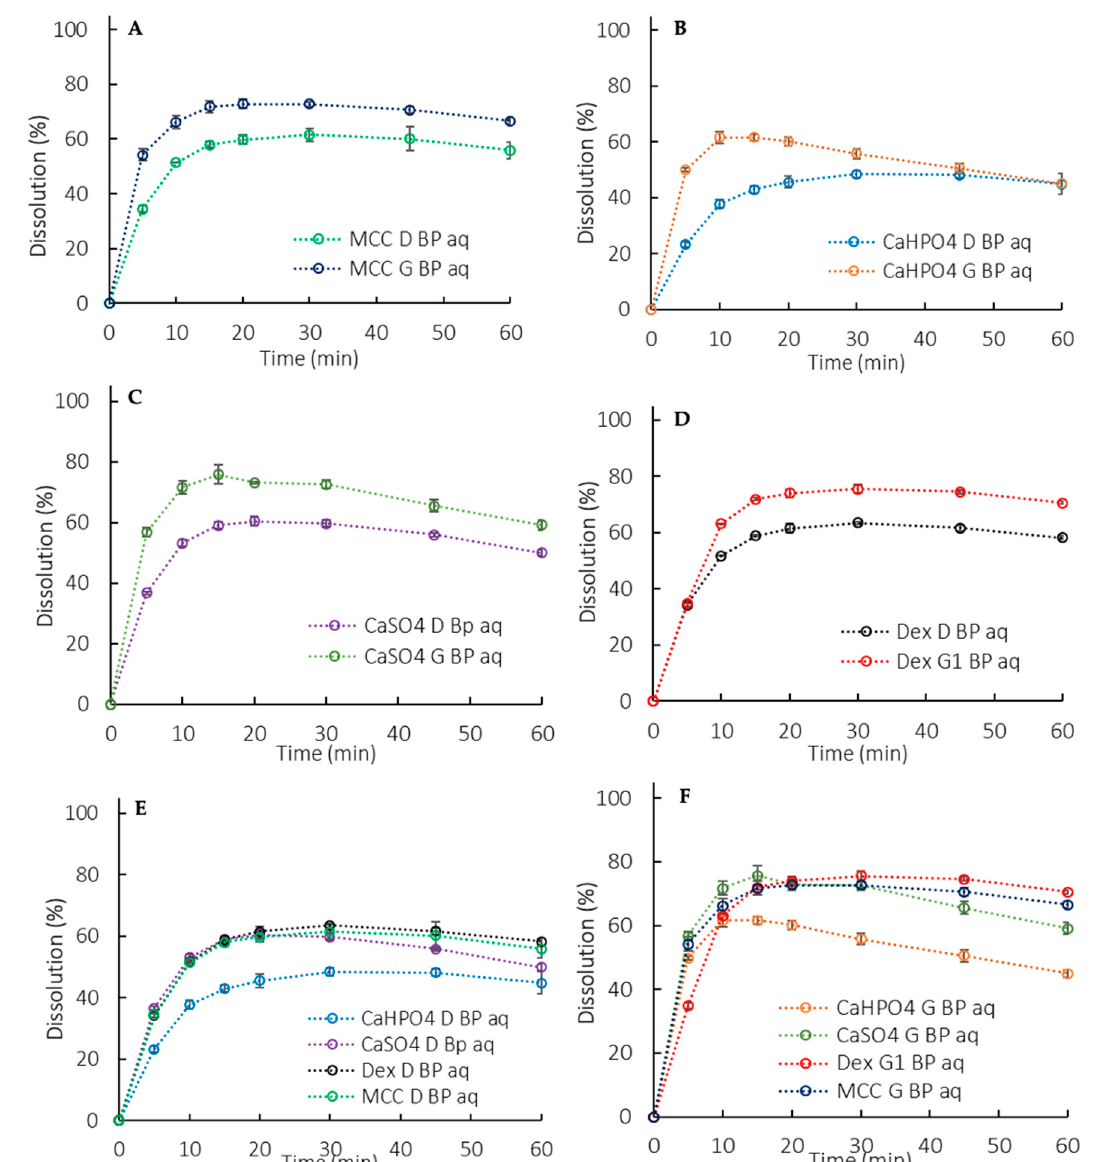
Figure 5. Aqueous phase dissolution profiles in a biphasic dissolution with 900 mL of aqueous media (BP aq). ( A ) MCC formulation, ( B ) CaHPO 4 formulation, ( C ) CaSO 4 formulation, ( D ) Dextrose formulation, ( E ) D formulations, ( F ) G formulations. Error bars represent the standard deviation.